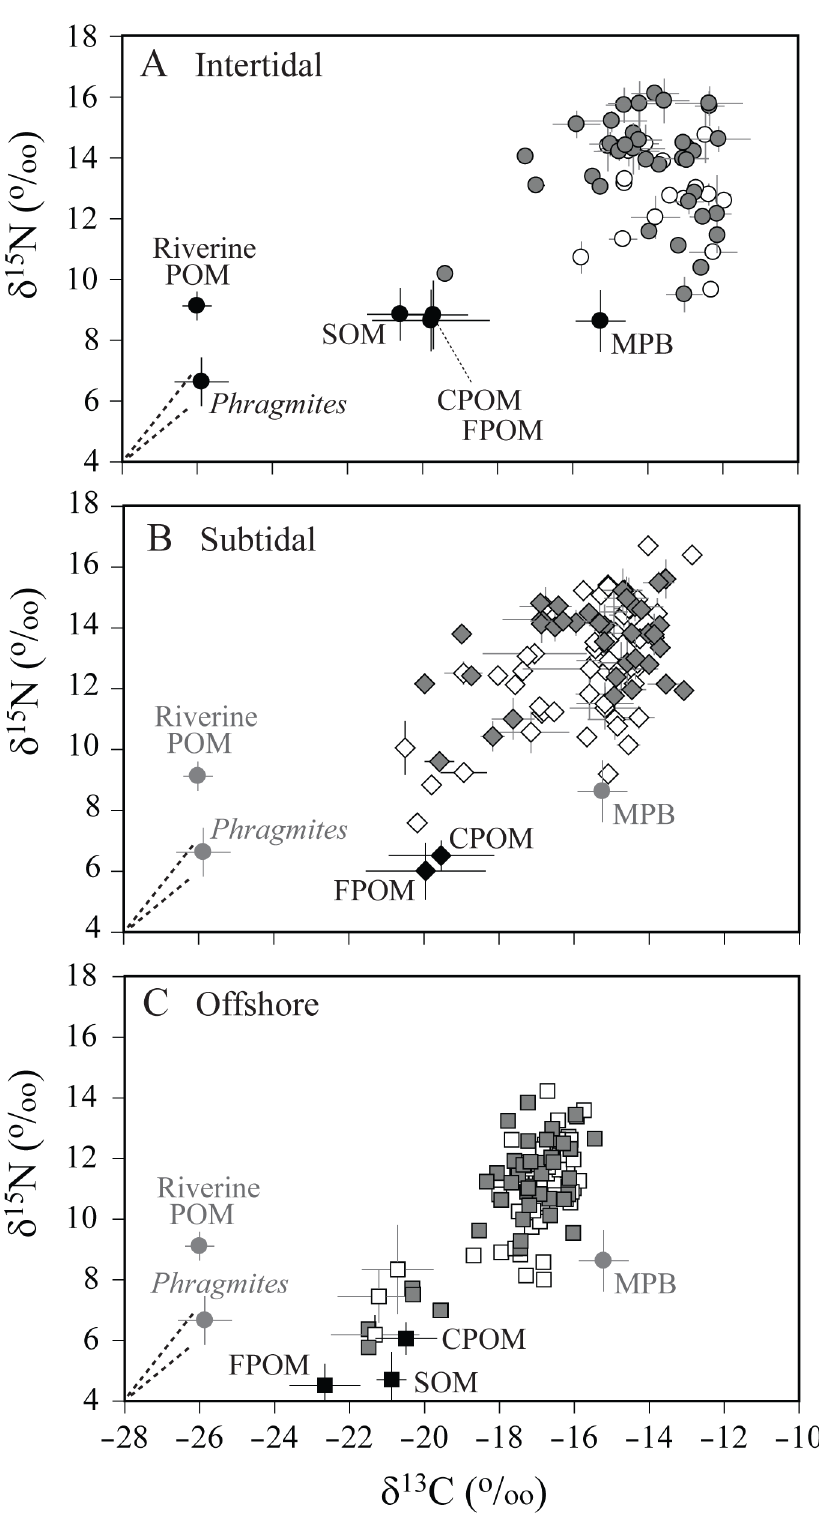
Fig 4. Dual plots of mean δ 13 C and δ 15 N values for food sources (black color) and consumers in spring (white) and fall (gray) in (A) intertidal, (B) subtidal, and (C) offshore habitats. Vertical and horizontal bars represent standard deviations. FPOM, fine ( < 20 μ m) suspended particulate organic matter;